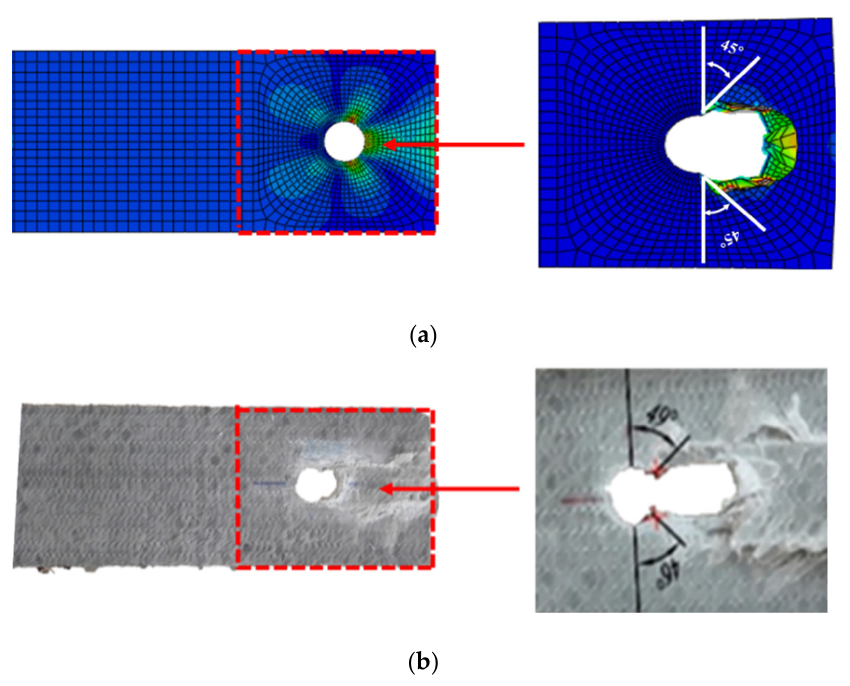
Figure 12. Maximum principal stress cloud of double − lap shear test of GFRP bolted joints .